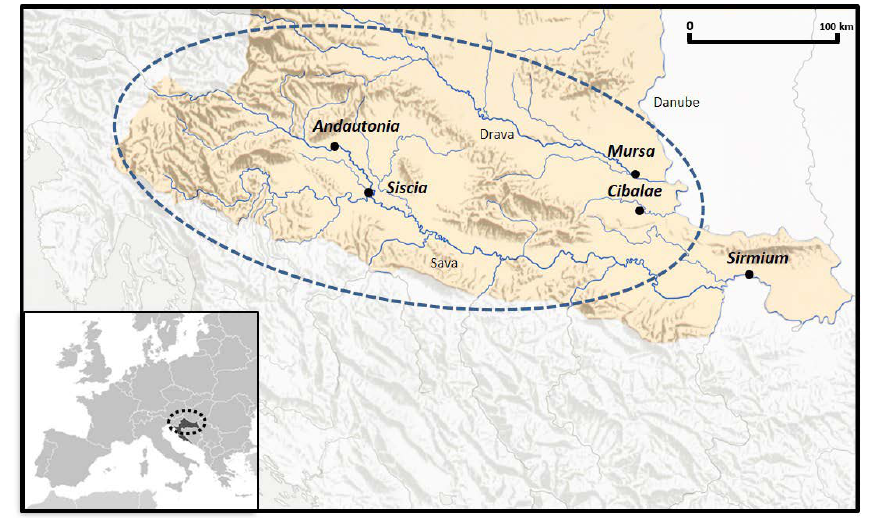
Figure 1: Map of southern Pannonia and the area under